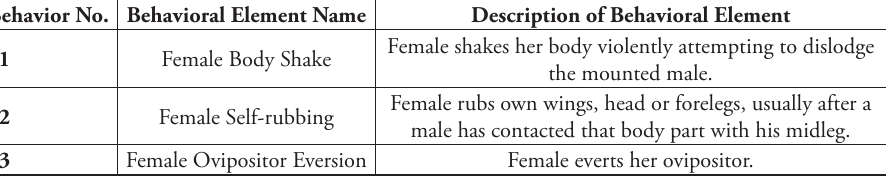
Table 5. Detailed description of observed female behavioral elements during